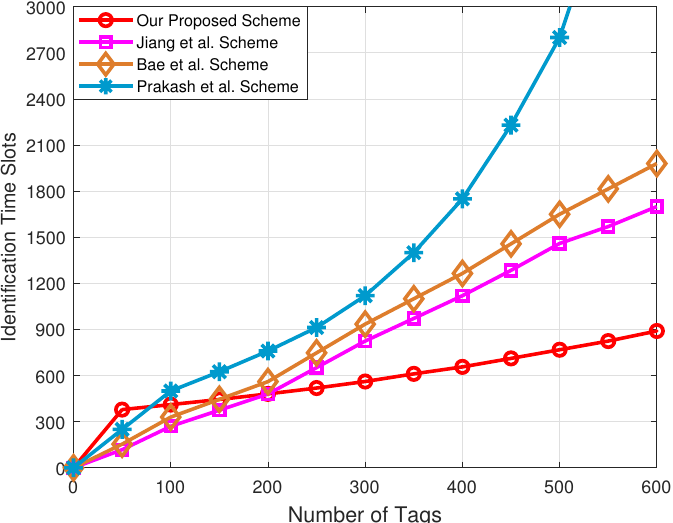
Figure 10. Comparison of the identification time slots with respect to the number of tags under the different